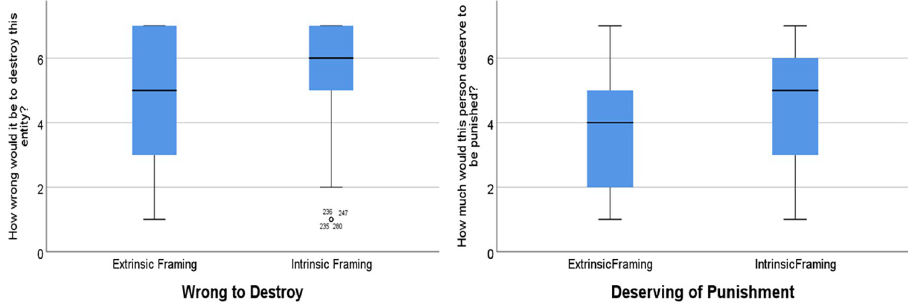
Fig 4. Destruction and punishment ratings intrinsic value vs. high extrinsic value entities (Study 5).